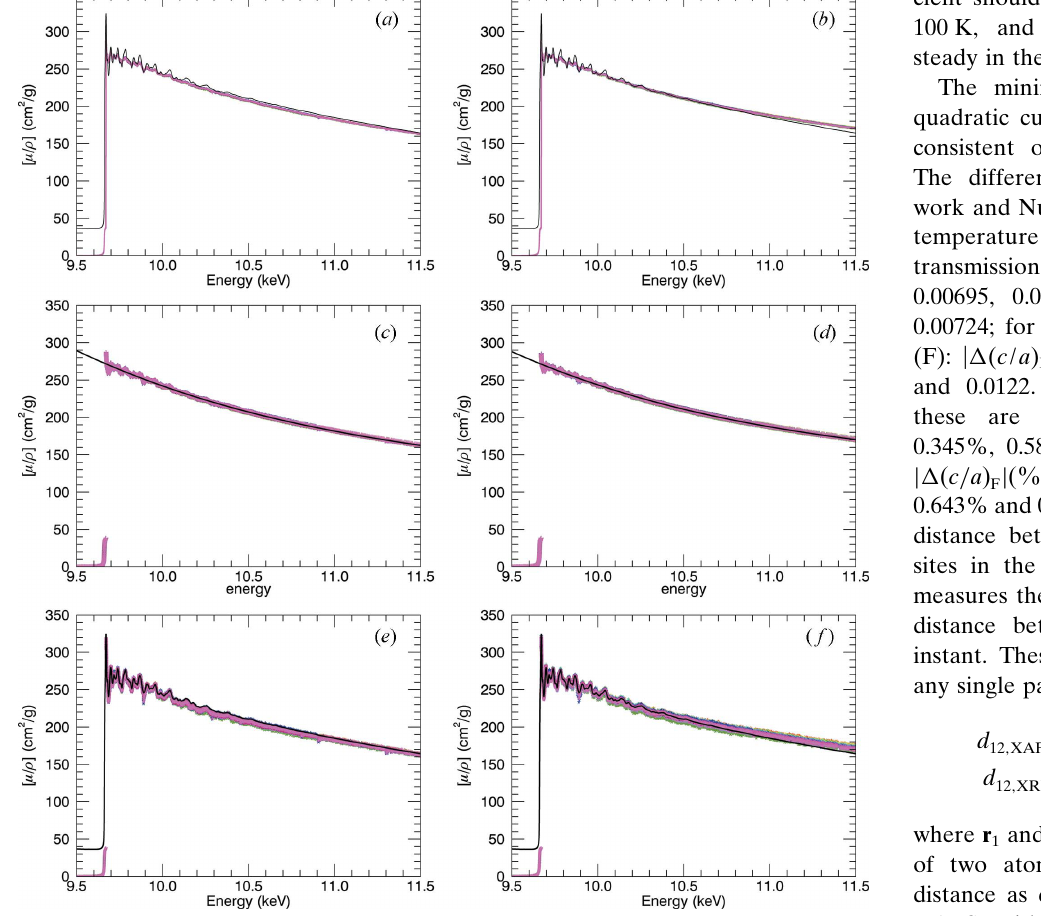
Figure 18 Processing incorporated into SeAFFluX to amplify oscillations and return an accurate set of mass attenuation coefficients. The left hand column ( a , c , e ) is 10 m m foil data and the right hand ( b , d , f ) is 50 m m foil data from the 10 K spectra. Panels ( a ) and ( b ) demonstrate the output of SeAFFluX and the shape of the slope. The 10 m m foil transmission spectrum is plotted (black line) in all panels. Panels ( c ) and ( d ) show basic spline fits; ( e ) and ( f ) show results after scaling the divergence relative to this